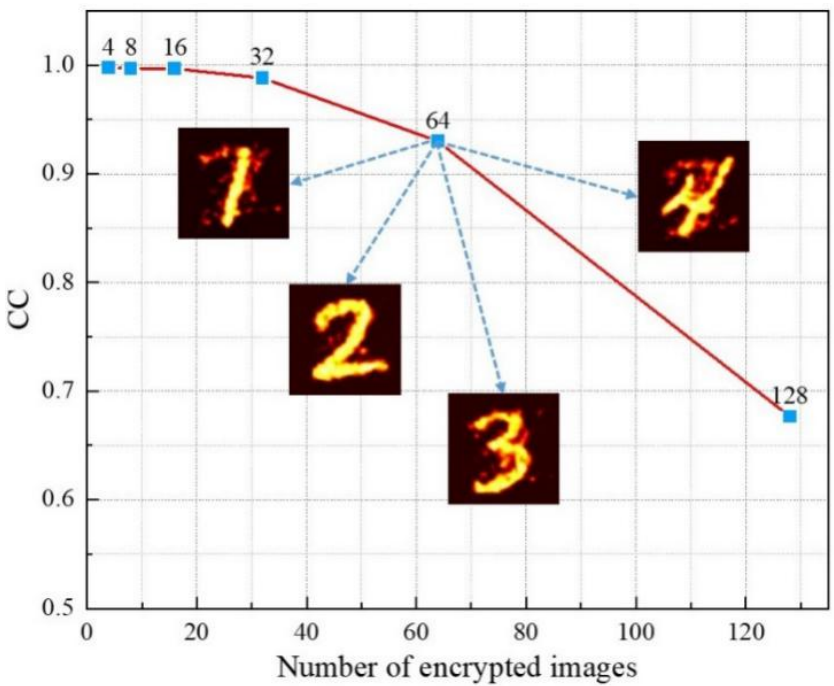
Figure 15. The relationship between the number of encrypted images and the quality of decrypted images.